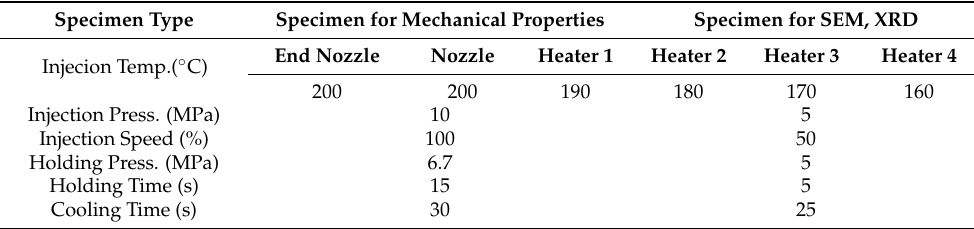
Table 3. Process conditions of injection molding